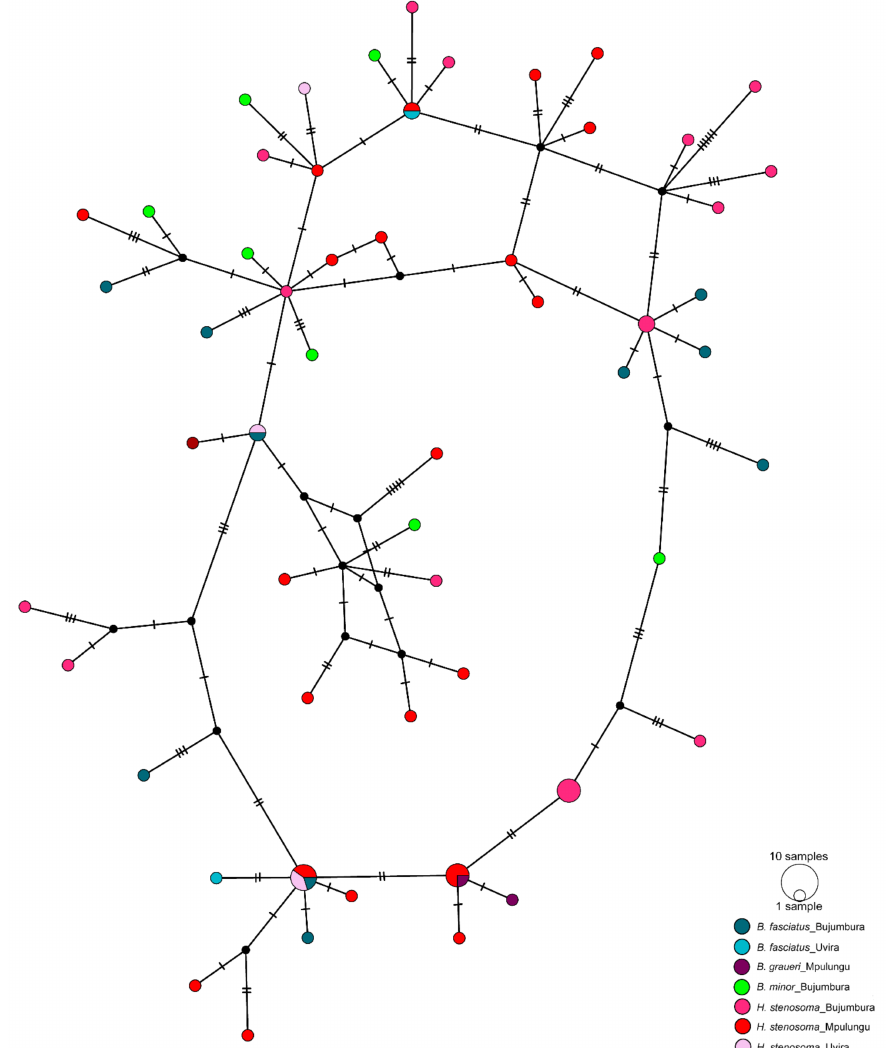
Figure 4. Genetic population structure of Cichlidogyrus casuarinus from Lake Tanganyika, East Africa, based on the mitochondrial cytochrome c oxidase subunit I ( cox 1) sequences. Median-joining haplotype network for worms recovered from four species of Bathybatini (see legend) at several locations across Lake Tanganyika. Coloured circles represent observed haplotypes where the size is proportional to the number of individuals sharing a